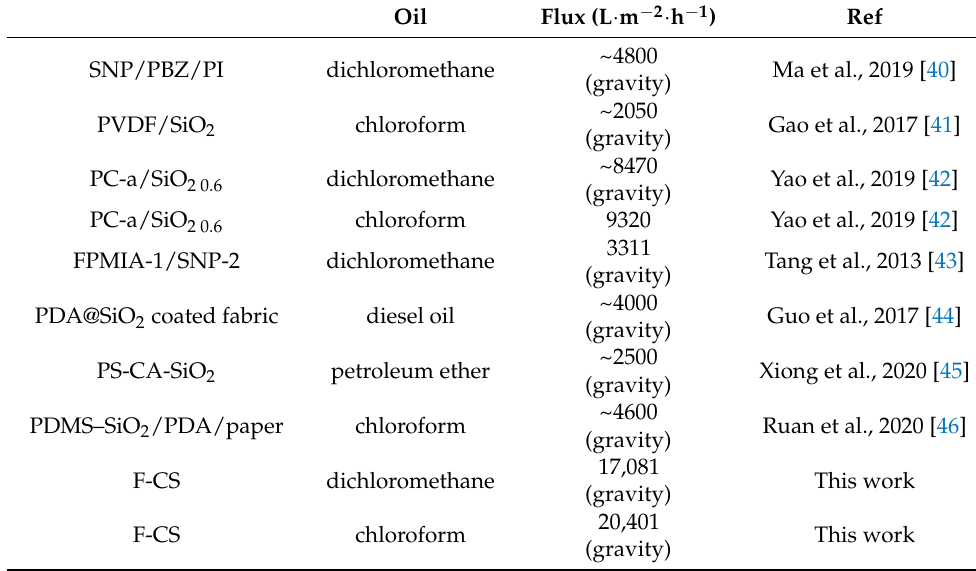
Figure 7. The processes of F-CS aerogel for separating a mixture of methylene blue dyed water and Oil red O dyed dichloromethane ( A ), separation efficiency ( B ), and separation fluxes of F-CS aerogel ( C , D ) driven by sole gravity. Table 1. Performance comparison of the reported silica functionalized materials.